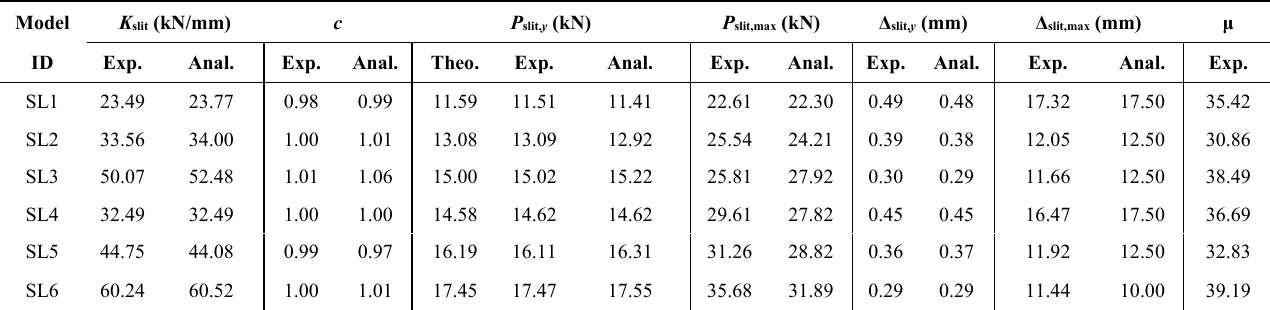
Table 2. Comparisons of experimental results to FE analysis results for steel slit damper models. Model K slit